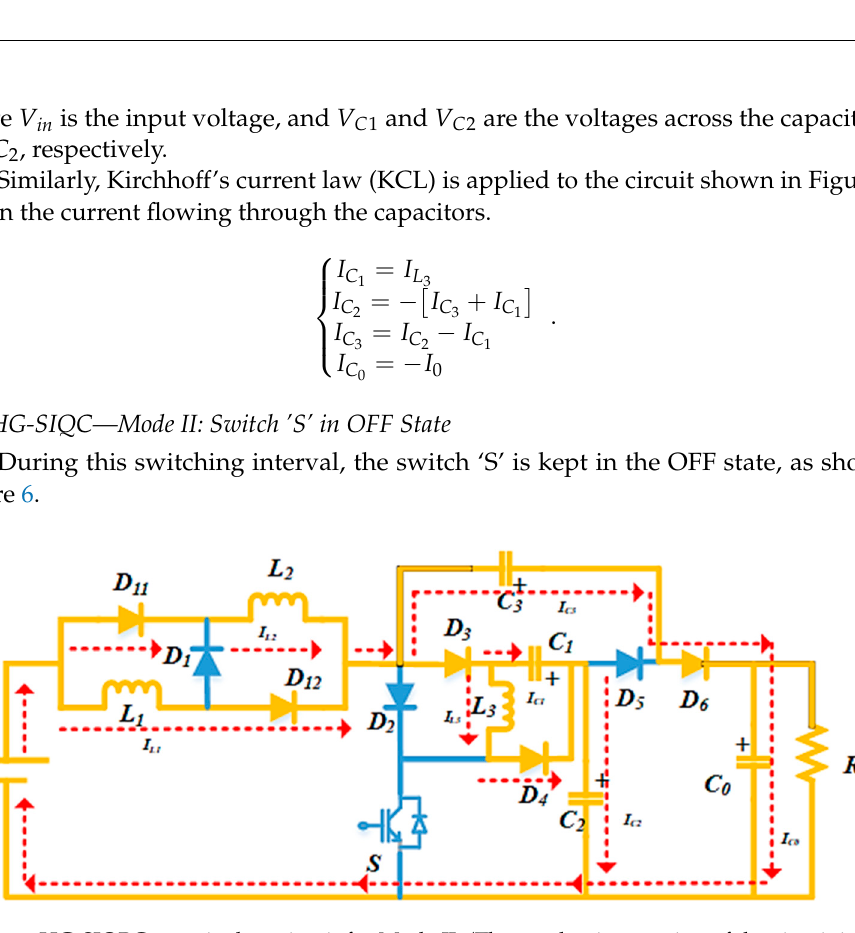
Figure 6 . HG-SIQBC—equivalent circuit for Mode II . (The conducting portion of the circuit is Figure 6. HG-SIQBC—equivalent circuit for Mode II. (The conducting portion of the circuit is shown shown in Yellow color with the current flow in dotted lines). in Yellow color with the current flow in dotted